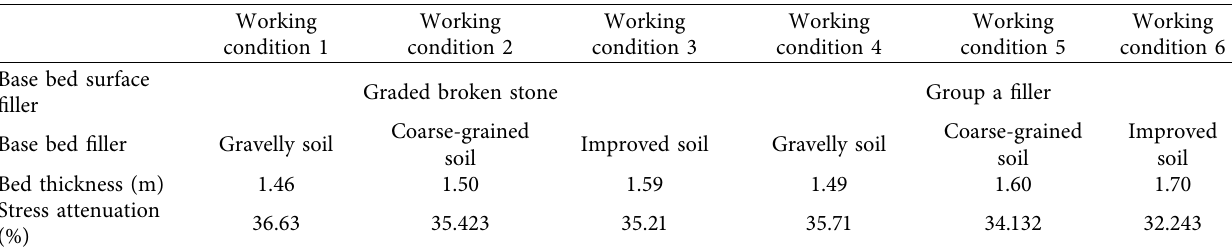
Table 4: Reasonable thickness of different bed